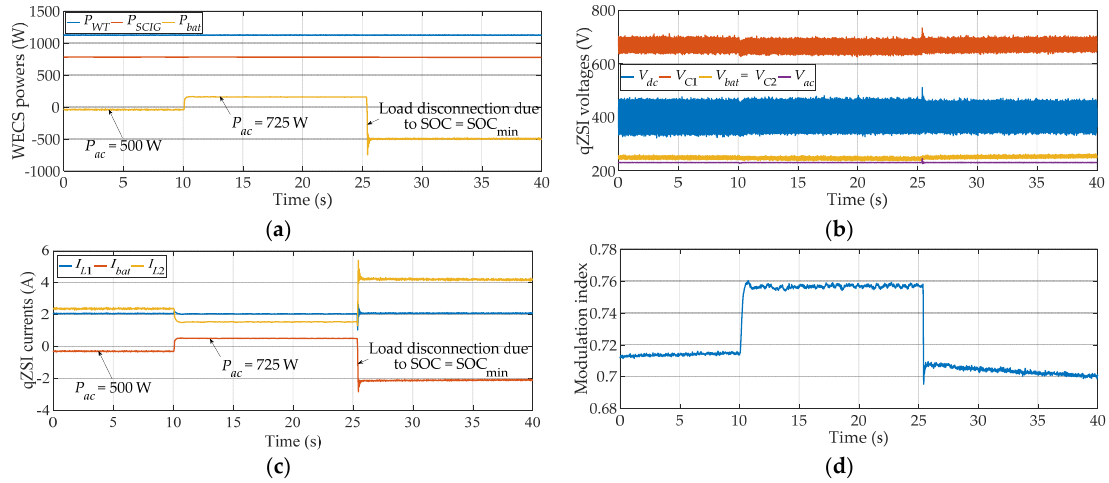
Figure 12. Dynamic responses for the case of minimum SOC: ( a ) WECS powers; ( b ) qZSI voltages; ( c ) qZSI currents; ( d ) modulation index.